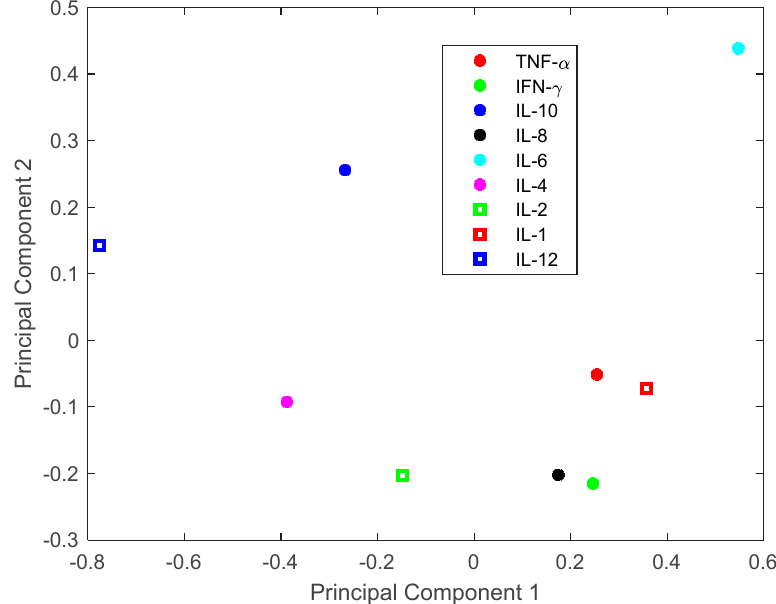
Figure 4. The projection of the 9 cytokines on the space of Principals one and two according to their peak values. (PCA: principal component analysis)